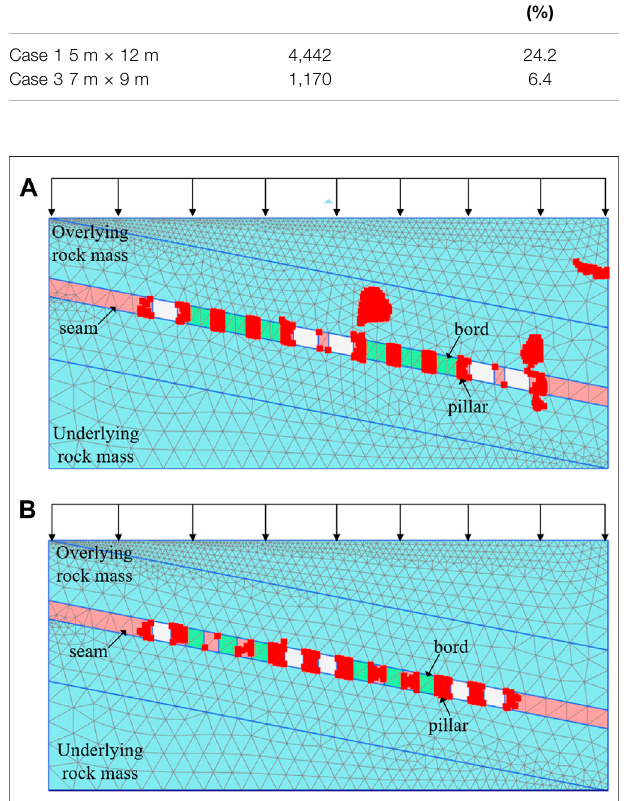
FIGURE 11 | | (A) Distribution of stope plastic area in Case 2 and 4. (B) Distribution of stope plastic area in Case 2 and 4.